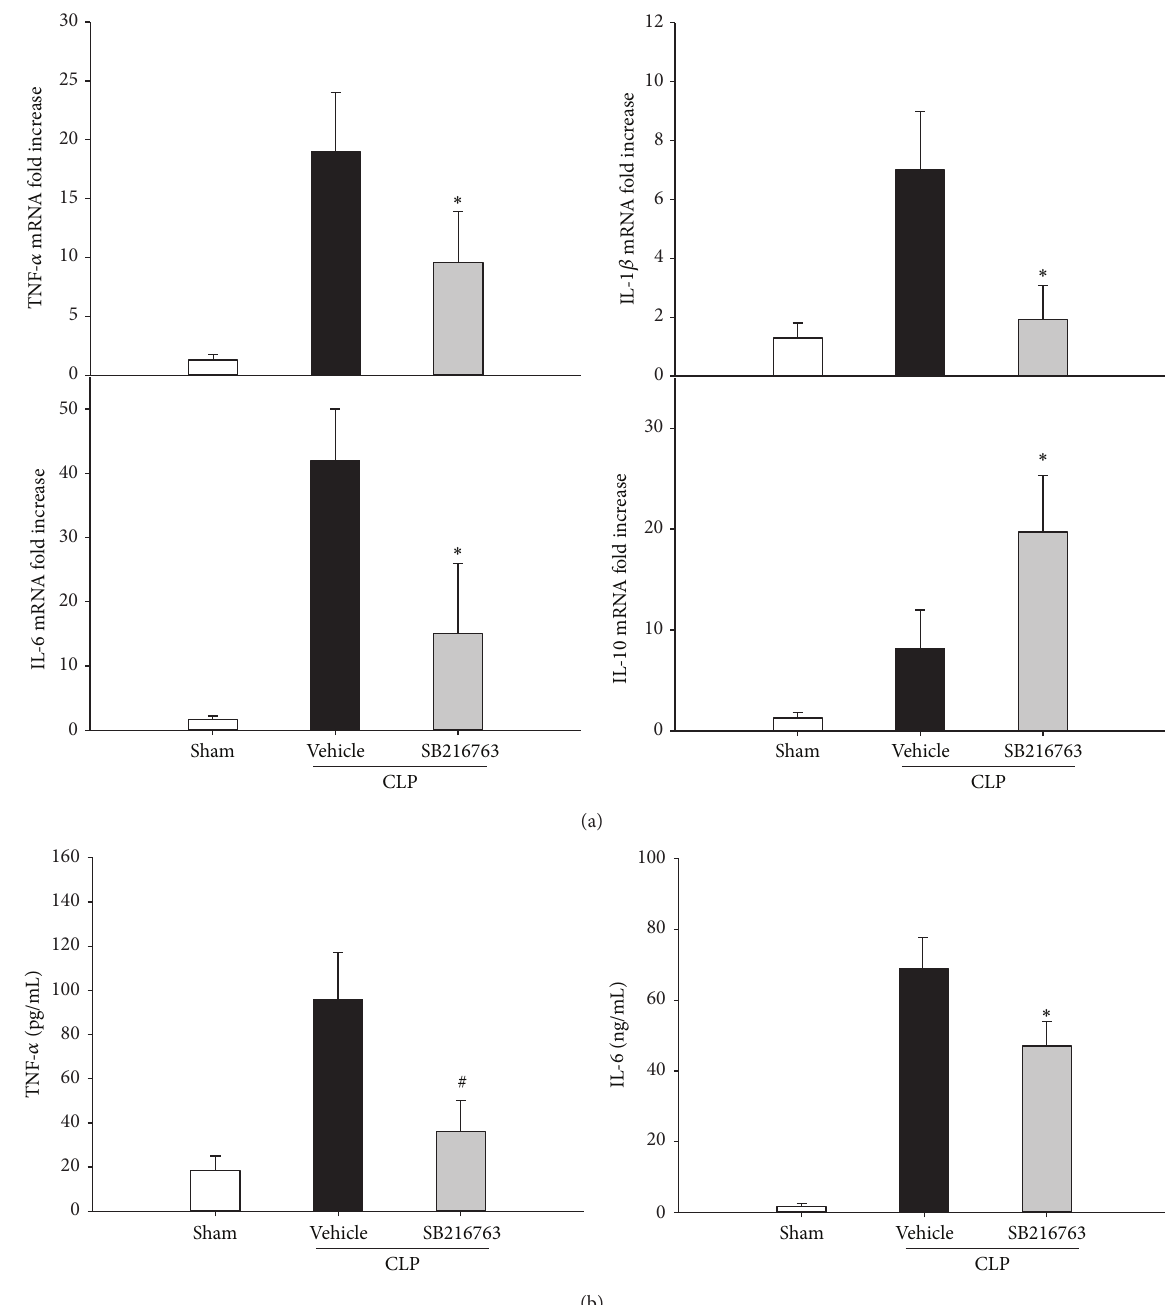
Figure 2: GSK-3 𝛽 inhibition attenuates the inflammatory cytokine production following CLP. (a) GSK-3 𝛽 inhibition altered mRNA expression of TNF- 𝛼 , IL-6, IL-1 𝛽 , and IL-10 in the liver of septic mice. (b) Serum TNF- 𝛼 and IL-6 levels were assessed by ELISA. Data are shown as mean ± SD. 𝑛 = 6 per group. ∗ 𝑃 < 0.05 , # 𝑃 < 0.01 compared with vehicle-treated